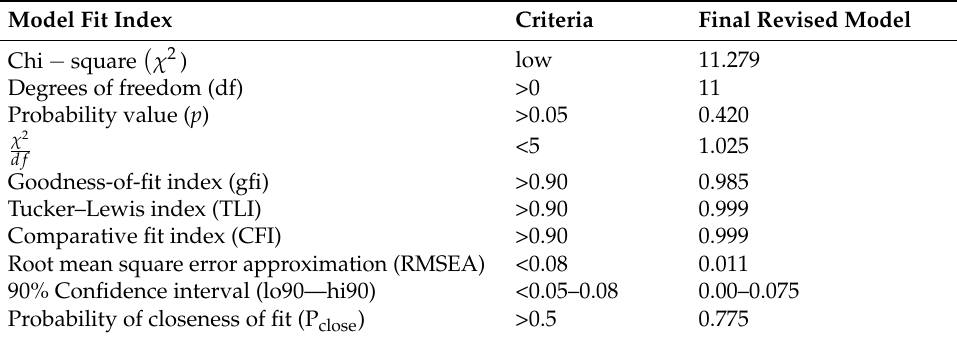
Table 9. Revised Structural Model Goodness of